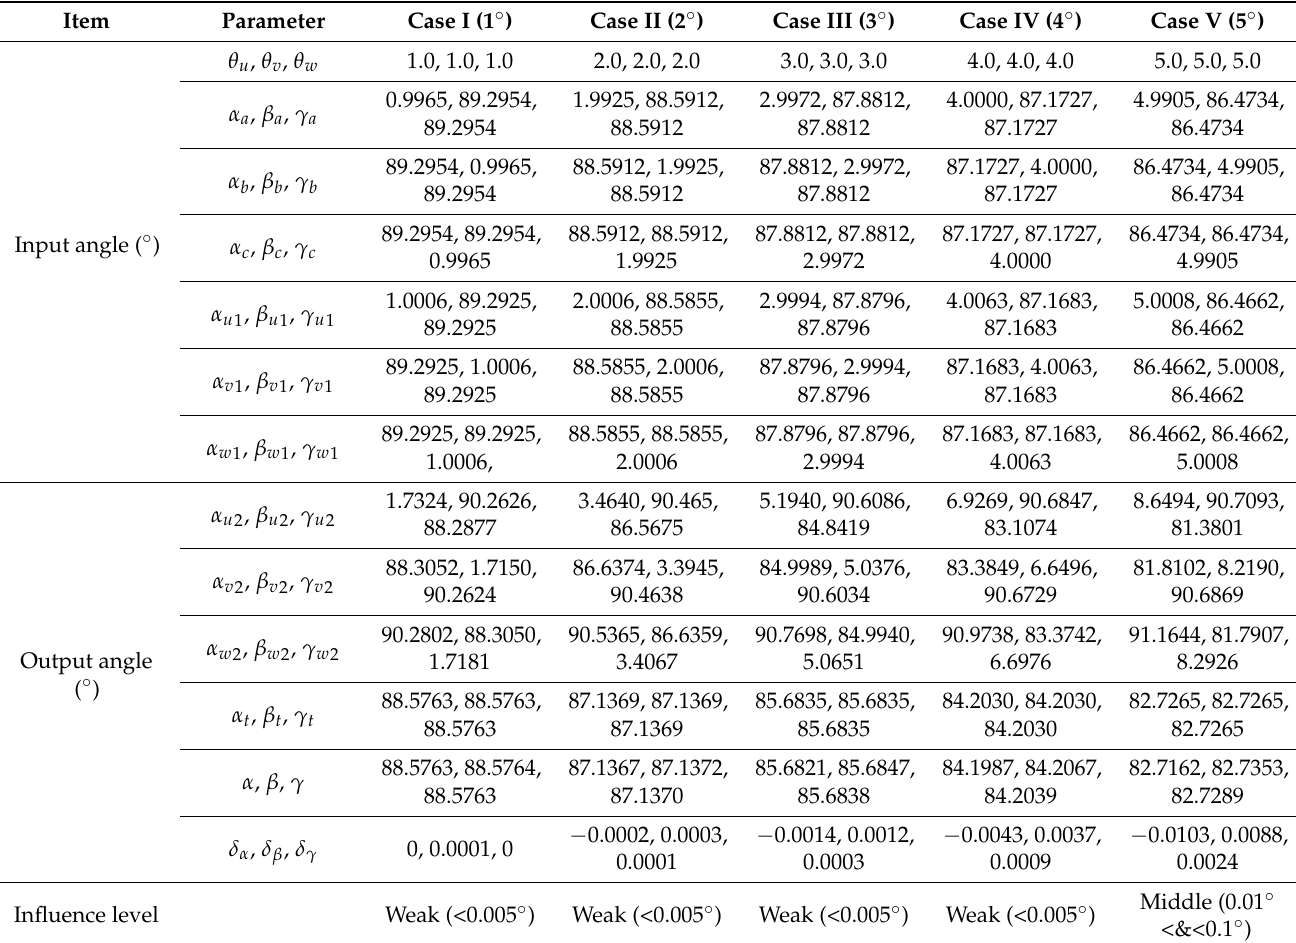
Table 2. The effects of error sources on orthogonality estimation under the angles: 1 ◦ –5 ◦